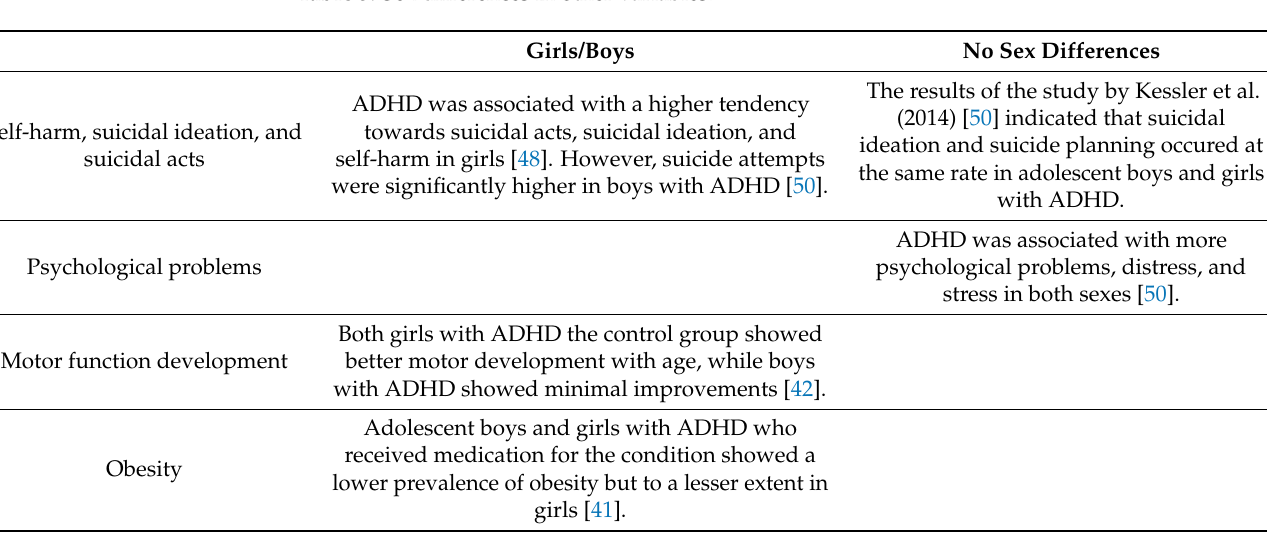
Table 5. Sex differences in other